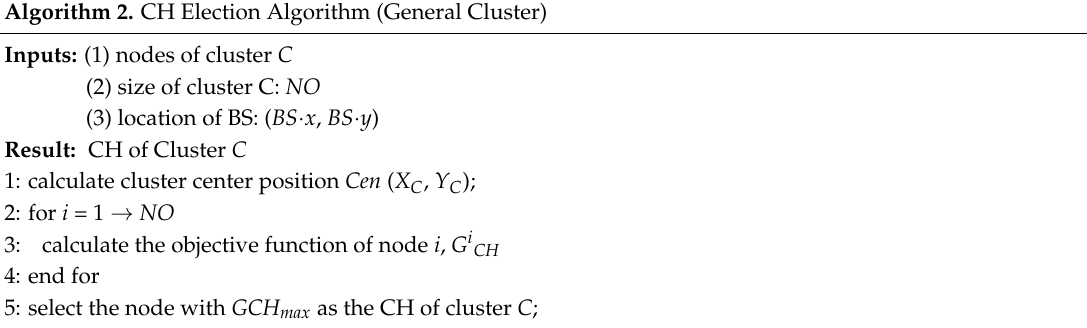
Algorithm 2. CH Election Algorithm (General